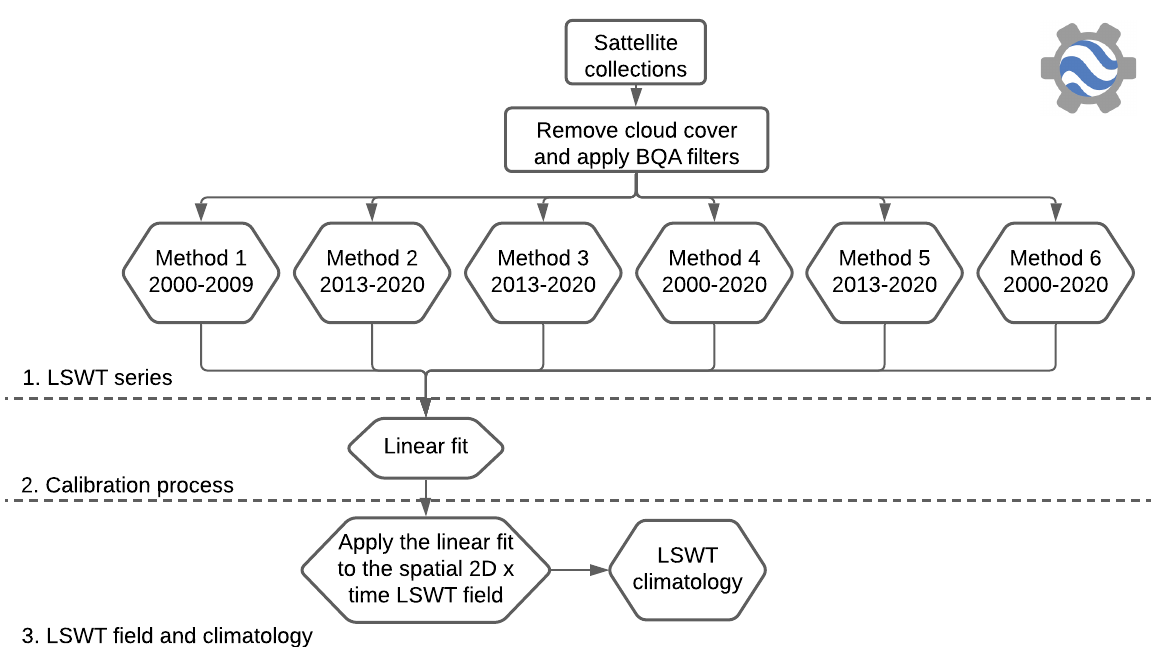
Figure 3. Work strategy flow chart. Within stage 1: preprocessing and six methods to retrieve LSWT series. Within stage 2: calibration of the LSWT series through a linear fit. Within stage 3: Extending the linear fit to a 2D × time LSWT field and building a